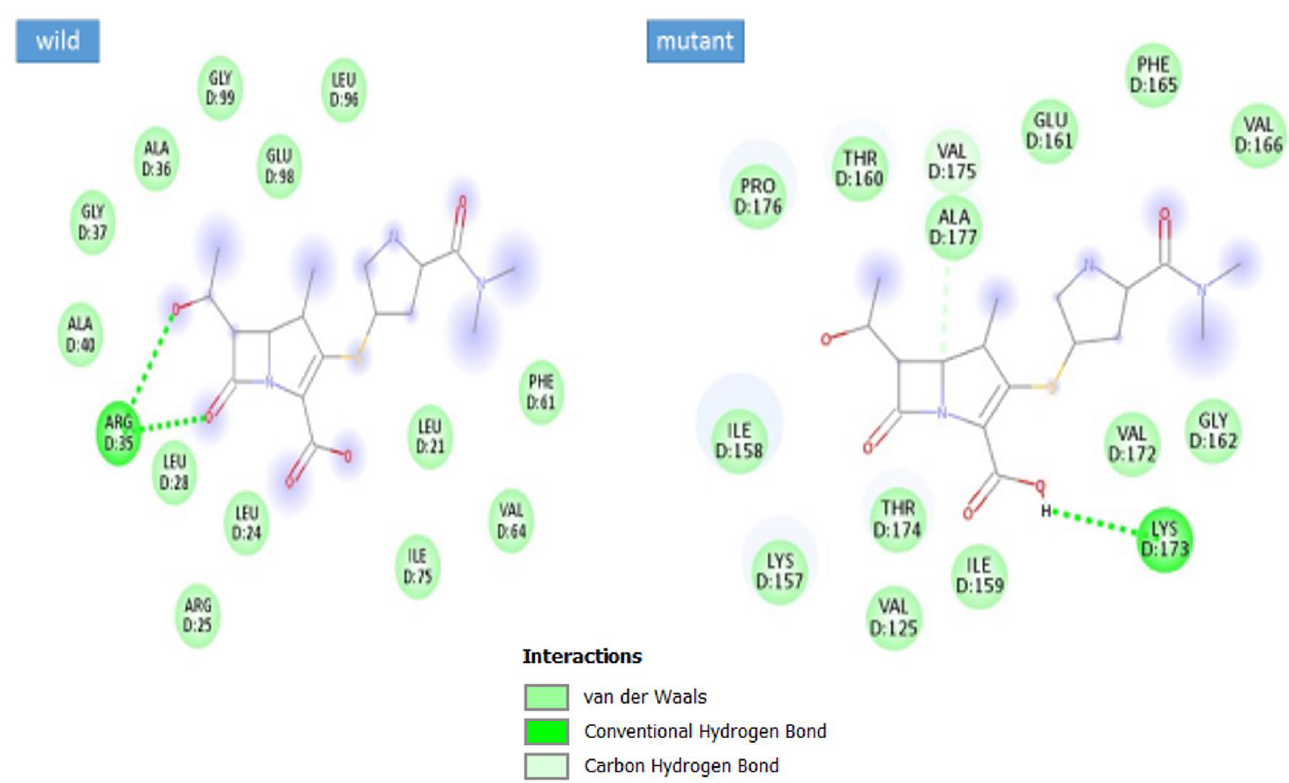
Figure 11. MexA wild and mutant binding interactions with meropenem. The compound is presented in a 2D line.